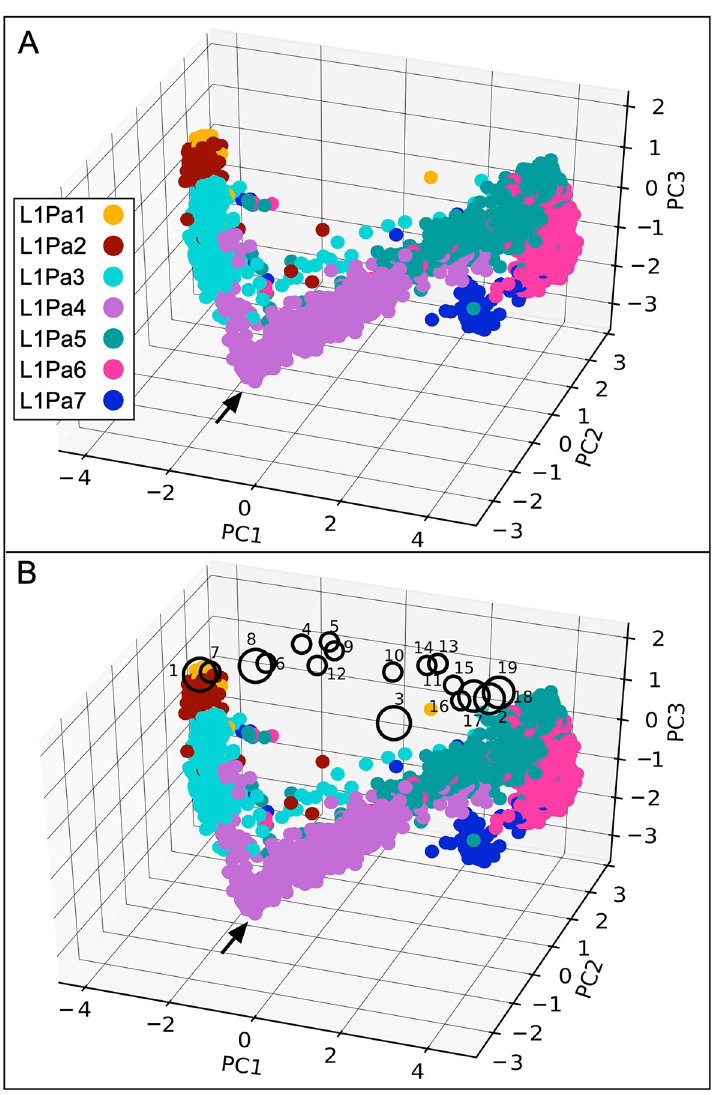
Fig 2. Principal component analysis of the ORF1p coiled coil. A —The color code used for each family corresponds to one of the major clusters shown in Fig 3. B —Large and small circles correspond respectively to active and inactive ORF1p variants mapped on the sequence space of the coiled coil of L1pa7-L1Pa1 and are numbered per Fig 1 and S3 Fig. Active variants (large circles) exhibited ~80–100% of L1Pa1 activity and inactive ones (small circles) < 5% of L1Pa1